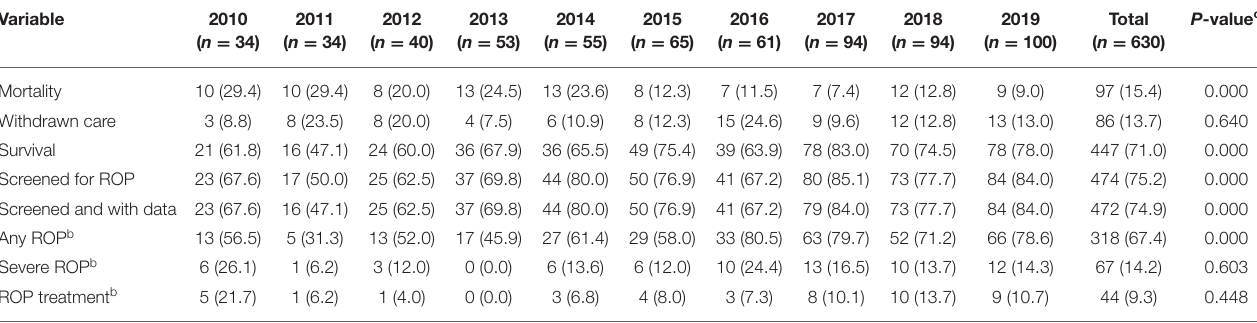
TABLE 1 | Rates of mortality, withdrawn care, survival, and ROP in extremely preterm infants from 2010 to 2019 a . Variable